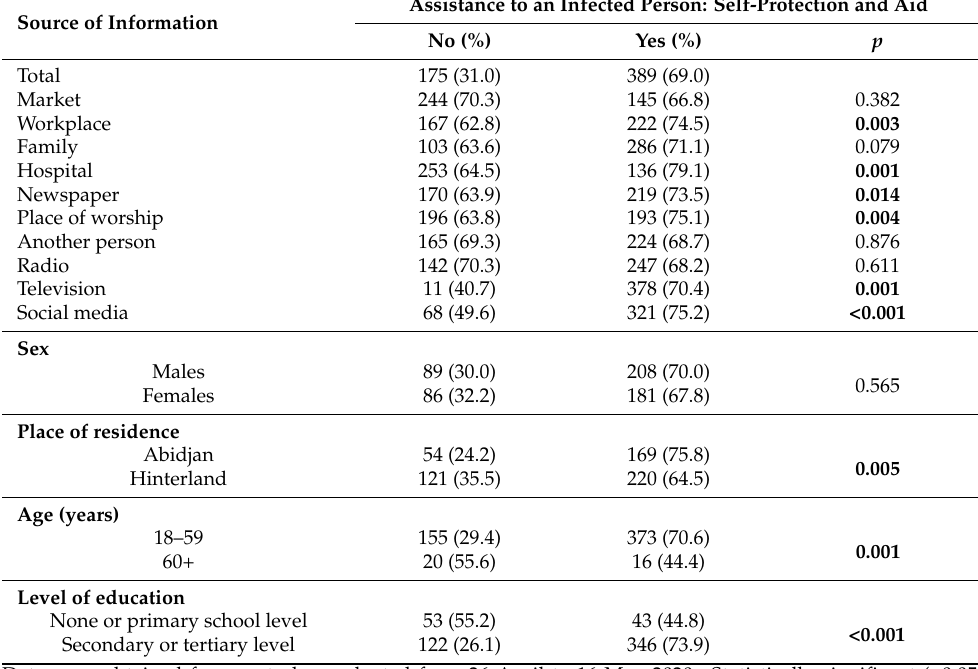
Table 3. Attitude towards a person infected with the COVID-19 according to sources of information and socio-demographic